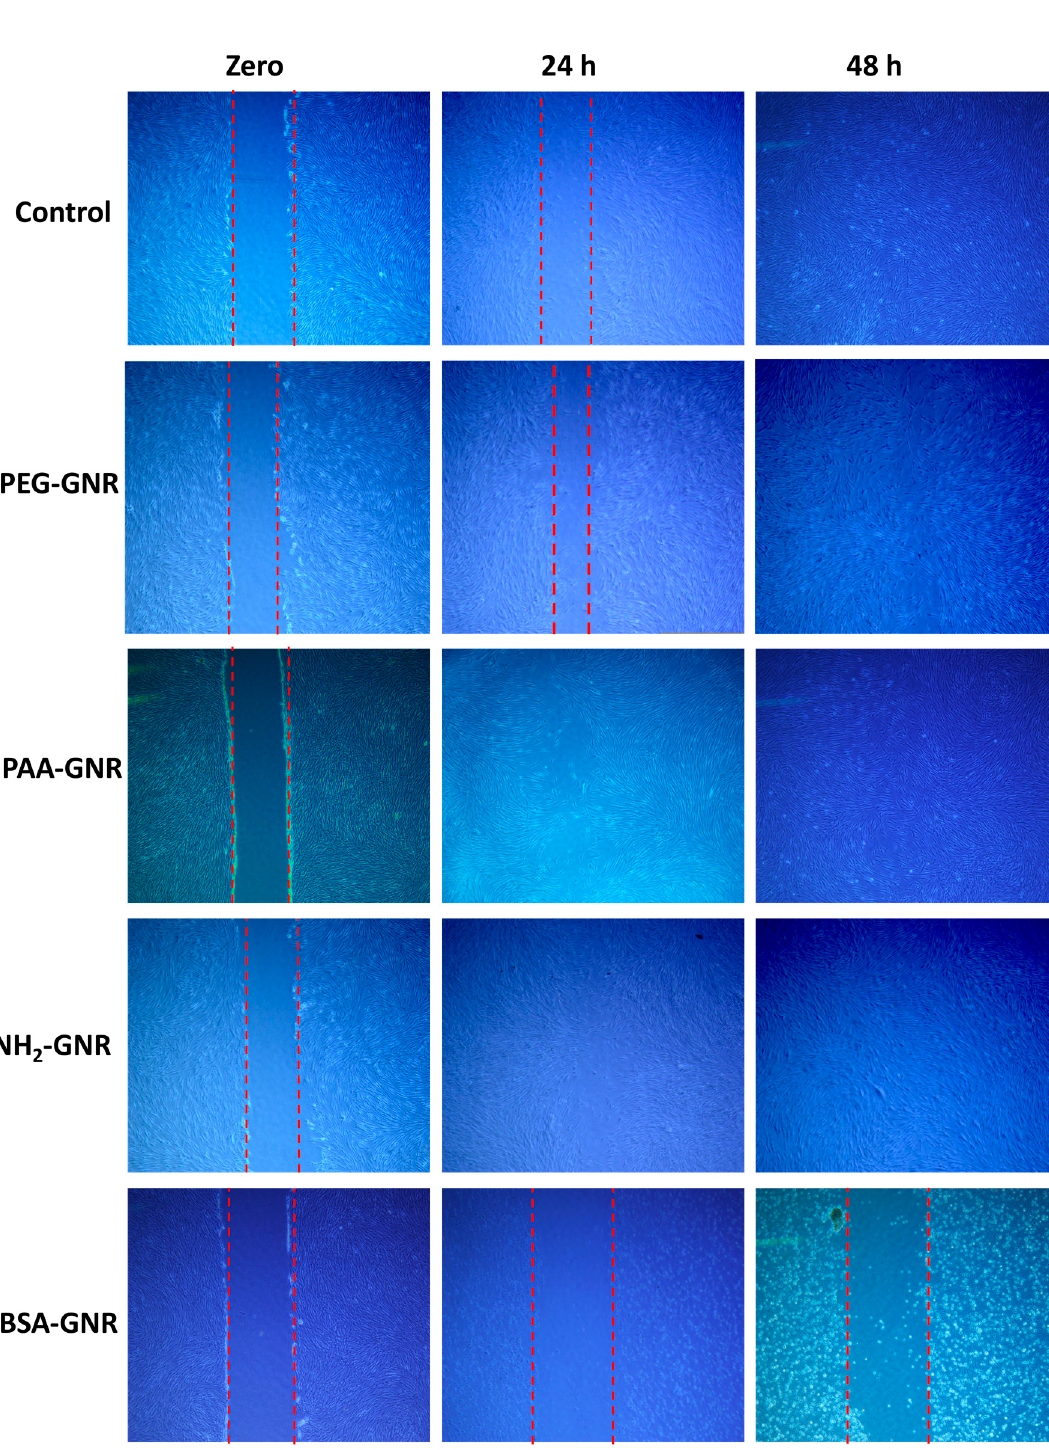
Figure 5. Wound healing ability of GNR of different surface modifications towards human dermal fibroblasts at different times of incubations. PEG-GNR, PAA-GNR and NH 2 -GNR enhanced the wound healing of scratched fibroblasts after 24 h of incubation compared to control, while BSA-GNR significantly retarded the wound healing of fibroblasts after 24 h and 48 h of incubation.